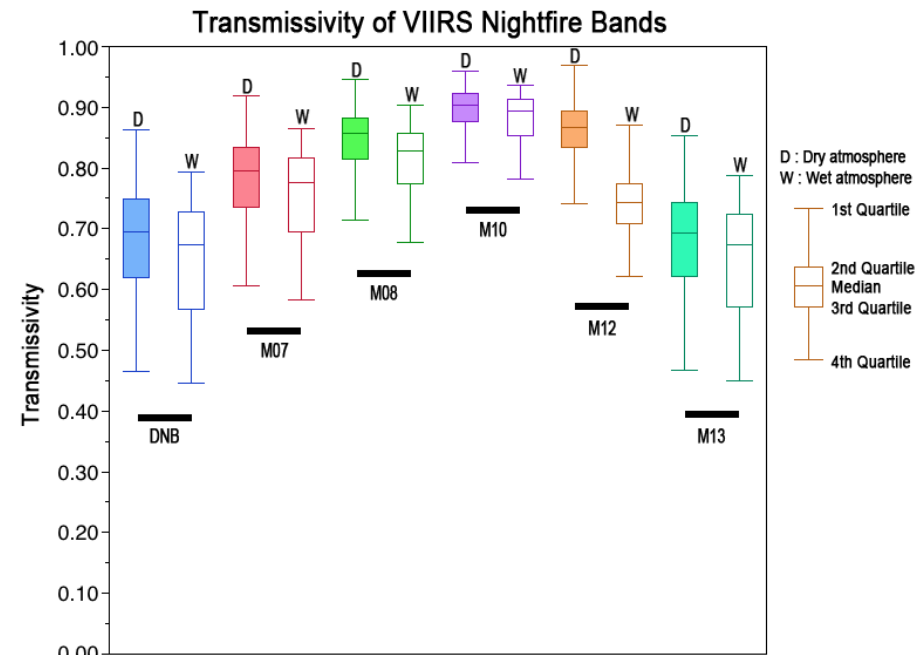
Figure 13. Plot of median and four quartiles for the MODTRAN derived transmissivity of the six spectral bands used in Nightfire for a wet and a dry atmosphere. Processed from Nightfire detections for 2 June